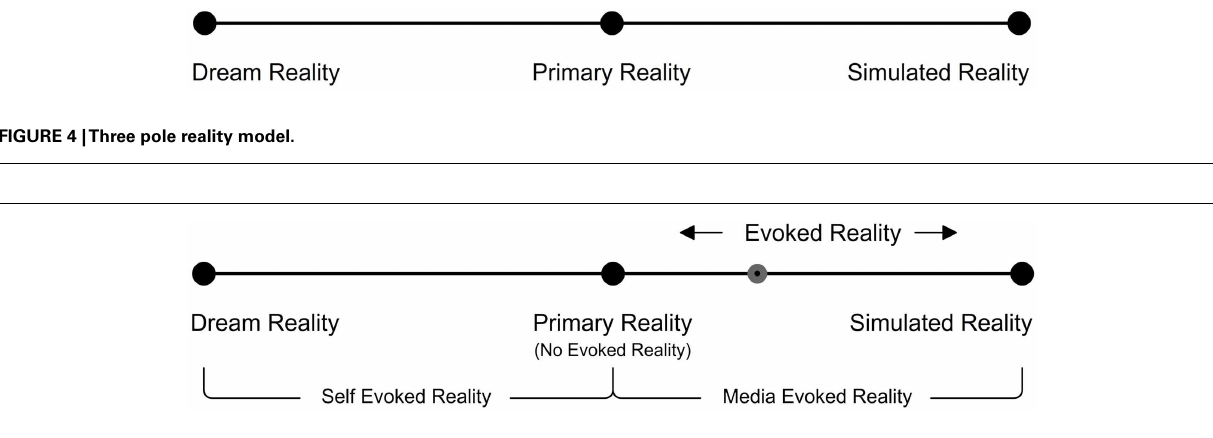
FIGURE 4 |Three pole reality model.